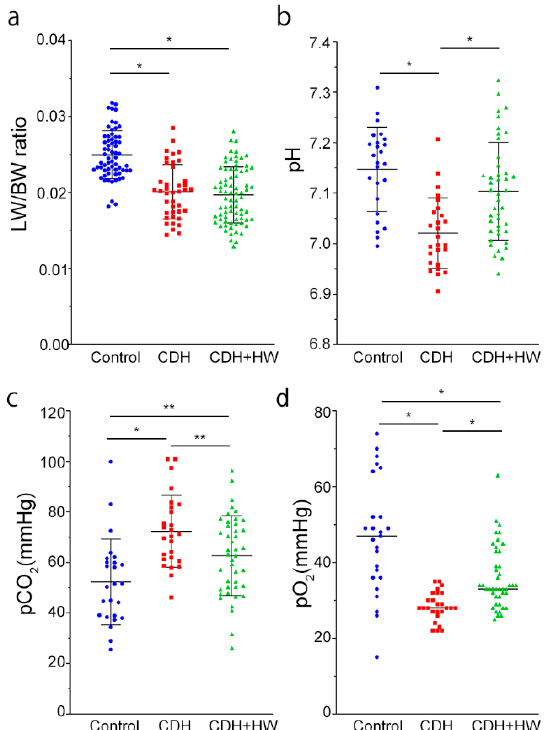
Figure 1. ( a ) The lung weight-to-body weight (LW/BW) ratio of control, congenital diaphragmatic hernia (CDH), and CDH + hydrogen-rich water (HW) pups. The LW/BW ratio in the CDH group was significantly lower than that in the control group, and was not improved by prenatal treat- ment with HW; ( b – d ) Neonatal blood pH ( b ), pCO 2 ( c ) , and pO 2 ( d ) were examined. Neonatal blood was harvested 5 min after birth. Prenatal HW treatment significantly ameliorated the results of blood gas tests compared with those in the CDH group. The bars represent the mean ± standard deviation (a-c) and median (d) for normal and non-normal distributions, respectively. * p < 0.01, ** p <